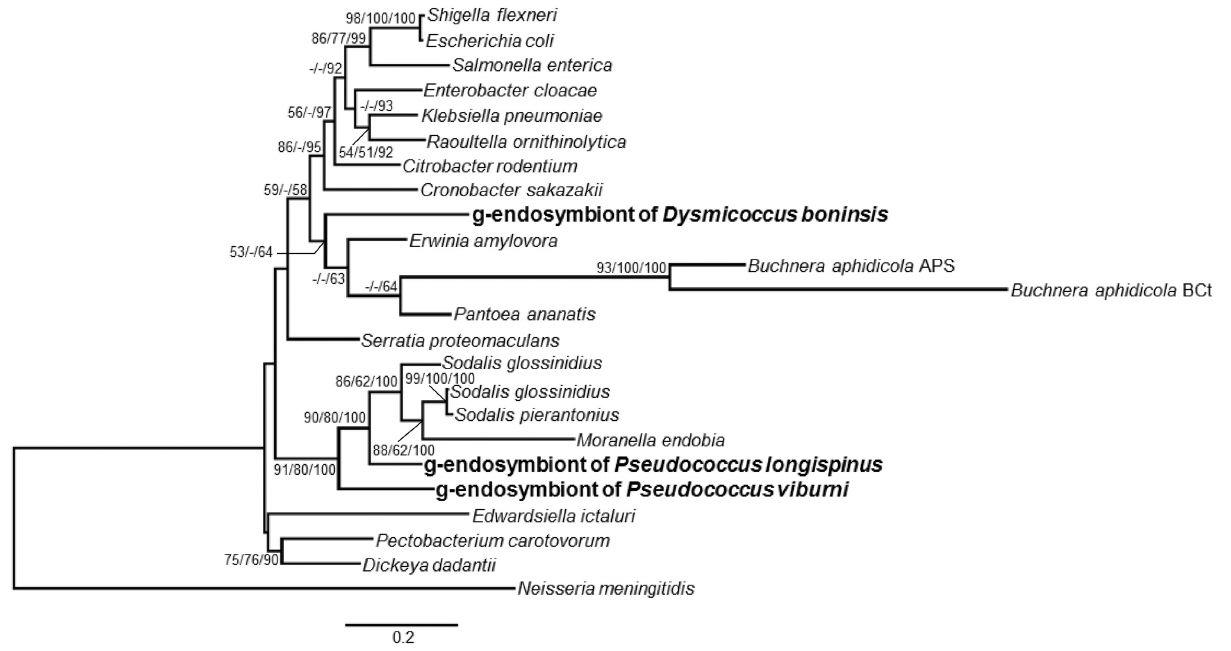
used as outgroup. Bayesian and MP analysis gave essentially the same results. ML and MP bootstrap values, and Bayesian posterior probabilities over 50% are represented. Scale bar represents substitutions per